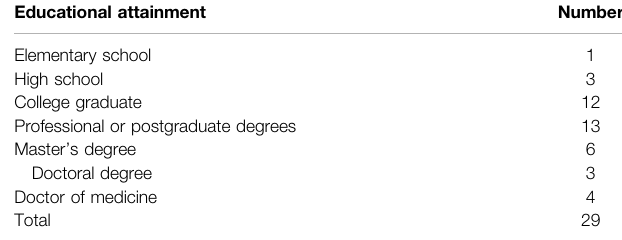
TABLE 2 | Educational attainment of interview